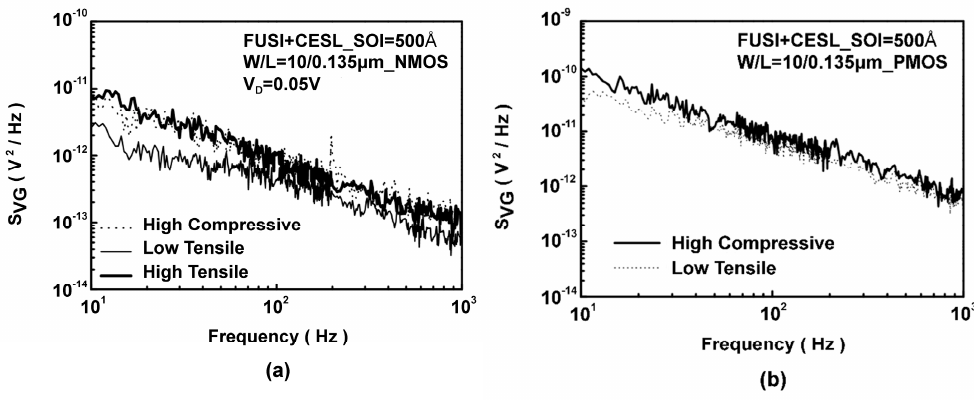
Figure 16. Influence of strain on flicker noise. Comparison of the effects of high- and low-tensile and high-compressive CESL on defects in ( a ) NMOS elements and ( b ) PMOS elements [13].